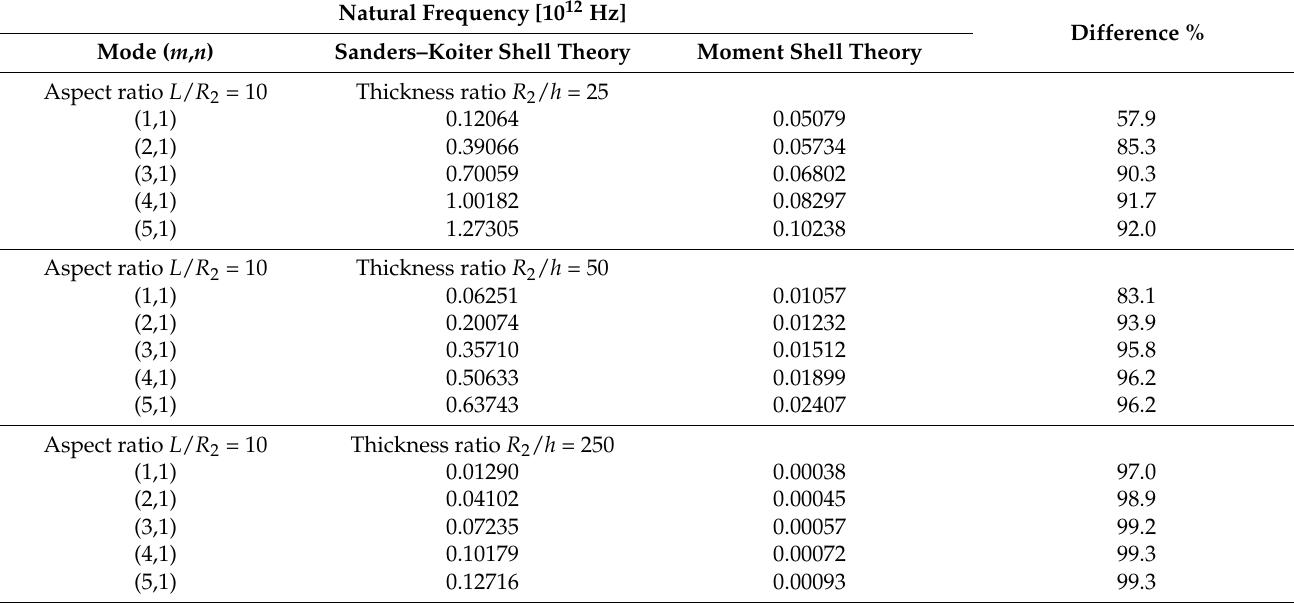
Table 12. Simply supported DWCNT with aspect ratio L / R 2 = 10 and thickness ratios R 2 / h = (25,50,250). Beam-like modes ( n = 1). Comparisons between Sanders–Koiter and moment shell theories.